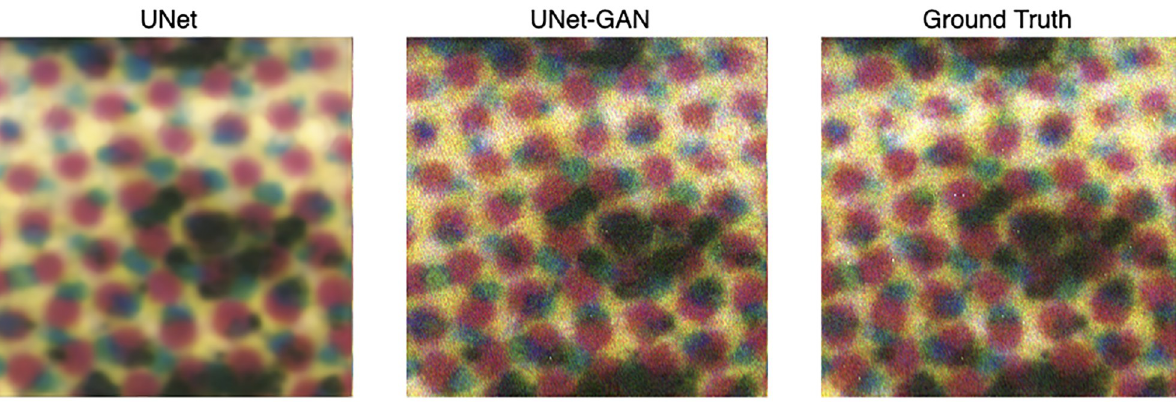
Fig 6. Visualization of the reconstructed RGB patches. (left) Patch generated by the UNet architecture. (middle) Patch generated by the UNet architecture with adverserial loss. (right) Ground truth RGB patch.